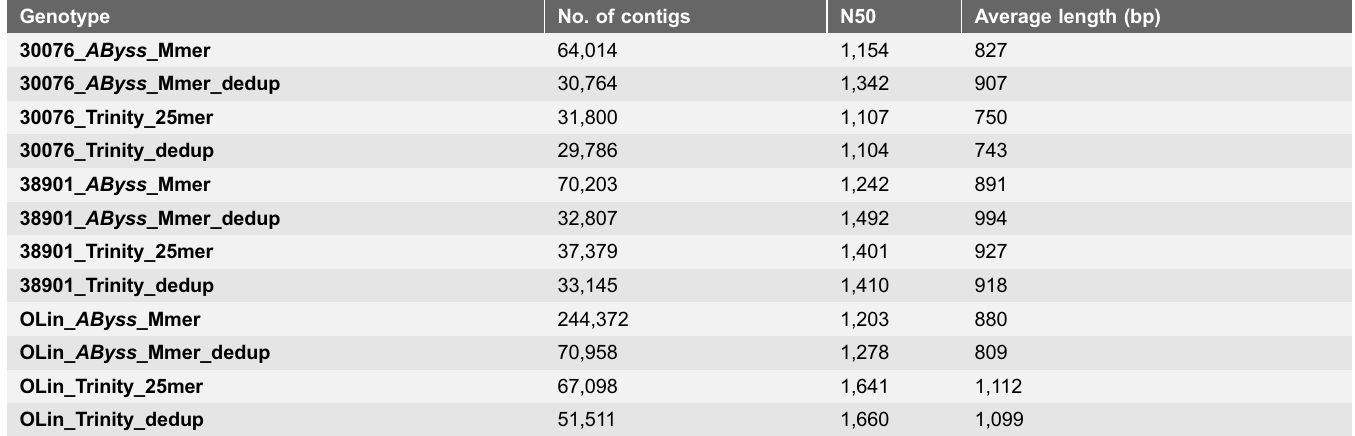
Table 3. Statistics on assemblies generated after merging multiple kmer assemblies using Trans- AByss and the non-redundant assemblies from Trinity and AByss [dedup – no redundant sequences, Mmer – multiple merged kmer assemblies]. Genotype